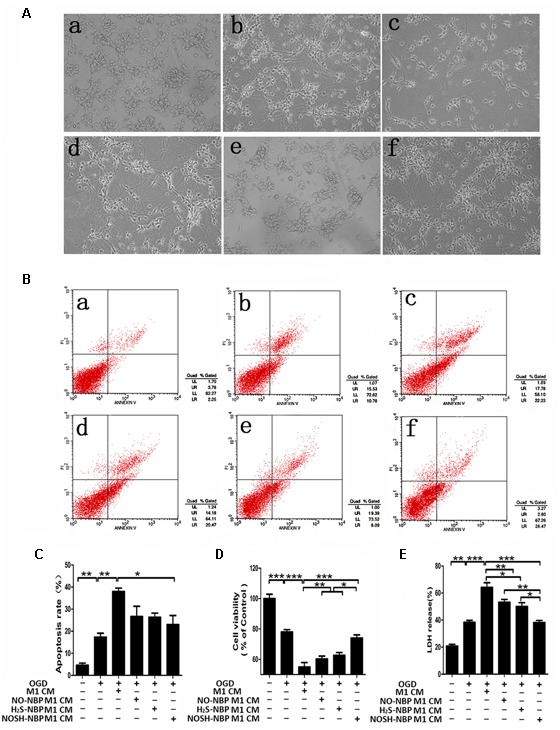
Effect of NO-NBP, H2S-NBP, or NOSH-NBP-treated M1 microglial condition medium on post-OGD primary neuronal survival. BV2 microglia were treated with LPS (100 ng/mL) + IFN-γ (20 ng/mL), NO-NBP (10 μM), H2S-NBP (10 μM), NOSH-NBP (10 μM) or a combination of these agents for 24 h, followed by the collection of conditioned media (CM). After 1 h OGD, primary neurons were incubated with different CM of microglia (M1 CM, NO-NBP M1 CM, H2S-NBP M1 CM, or NOSH-NBP M1 CM), respectively. (A) Photographs of mouse cortical neurons taken by phase-contrast microscopy: (a) Control, (b) OGD, (c) OGD + (d) OGD + NO-NBP M1 CM, (e) OGD + H2S-NBP M1 CM, (f) OGD + NOSH-NBP M1 CM groups. (B) A representative image of neuronal apoptosis. (C) Quantitative analysis of neuronal apoptosis (n = 3). (D) Quantitative analysis of cell viability percentage (n = 6). (E) Quantitative analysis of LDH release percentage (n = 6). Data are mean ± SD and were analyzed by one-way ANOVA followed by post hoc Tukey test: ∗∗∗P < 0.001, ∗∗P < 0.01, ∗P < 0.05.